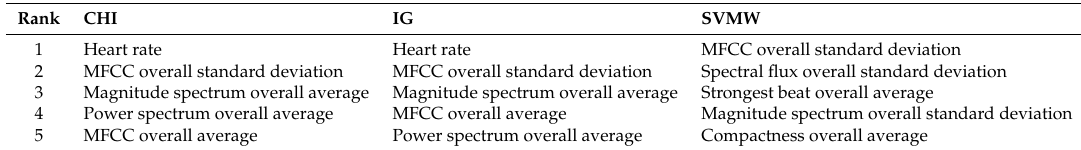
Table 5. Top five selected features according to the three feature selection methods (chi-square, CHI; information gain, IG; and support vector machine wrapper, SVMW), according to their ranks.